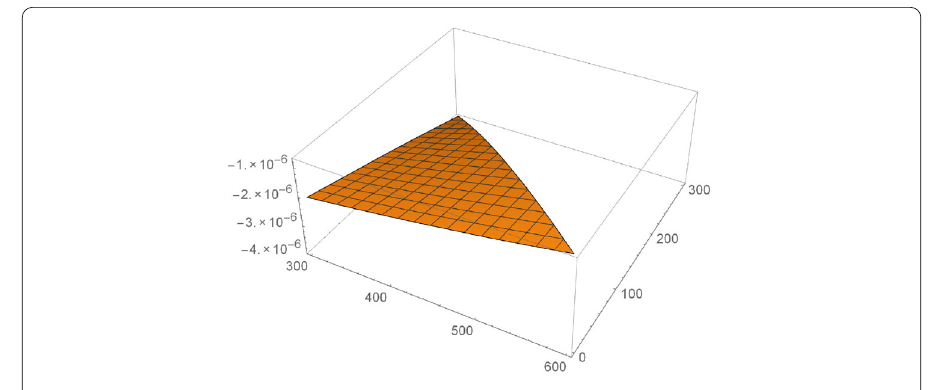
Figure 4 Error analysis chart on B 1